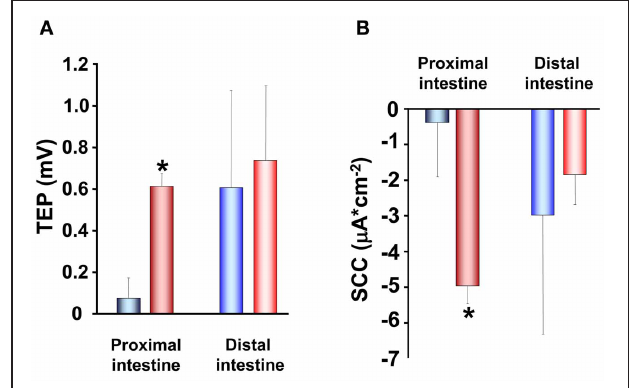
FIGURE 4 | Transepithelial potential (TEP; A) and short-circuit current (SCC; B) in proximal and distal regions of the intestinal tract of fresh water ( , ) and seawater ( , ) adapted rainbow trout ( n = 8). Asterisks indicate significant differences between FW- and SW-acclimated trout. All data are expressed as mean values ± SEM. Differences in the parameters measured are analyzed using Two-Way ANOVA of variance, followed by Student Neuman Keuls post hoc procedure. Significance was accepted at p < 0 . 05 (see Sundell et al., 2003; Jutfelt et al., 2007; Sundh et al.,